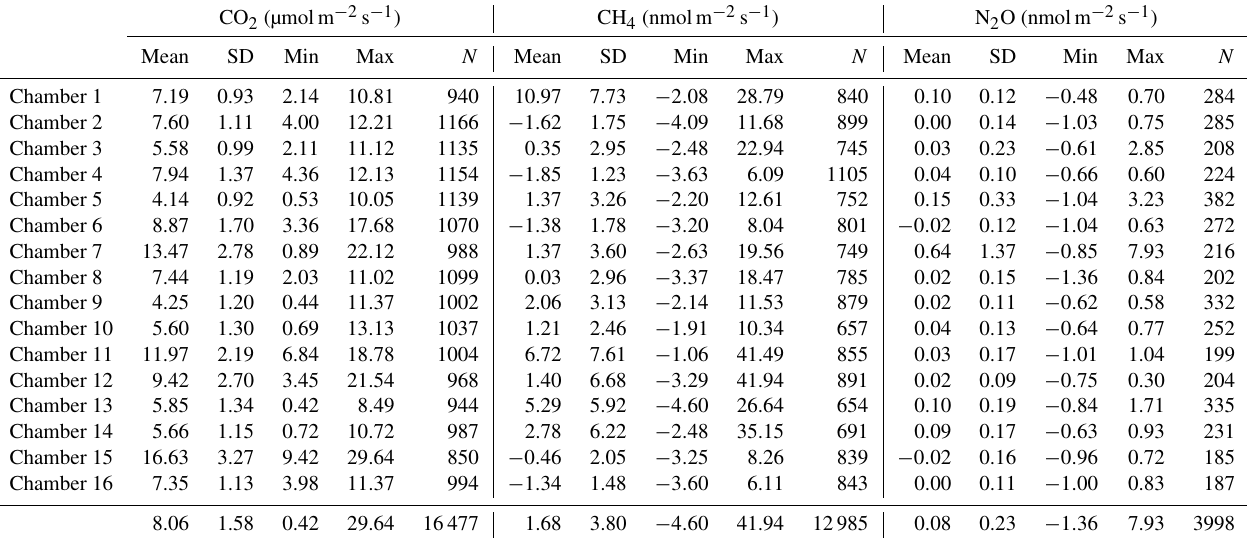
Table 2. Mean, standard deviation (SD), minimum (Min), and maximum (Max) values of each gas and each chamber over the study period. These values are computed using all flux estimations (with either SHORT or LONG closure times) remaining after quality check. The number ( N ) of fluxes that were used is also indicated for each chamber. The last line of the table is the mean of all fluxes by chamber by gas and the min and max for all chambers by